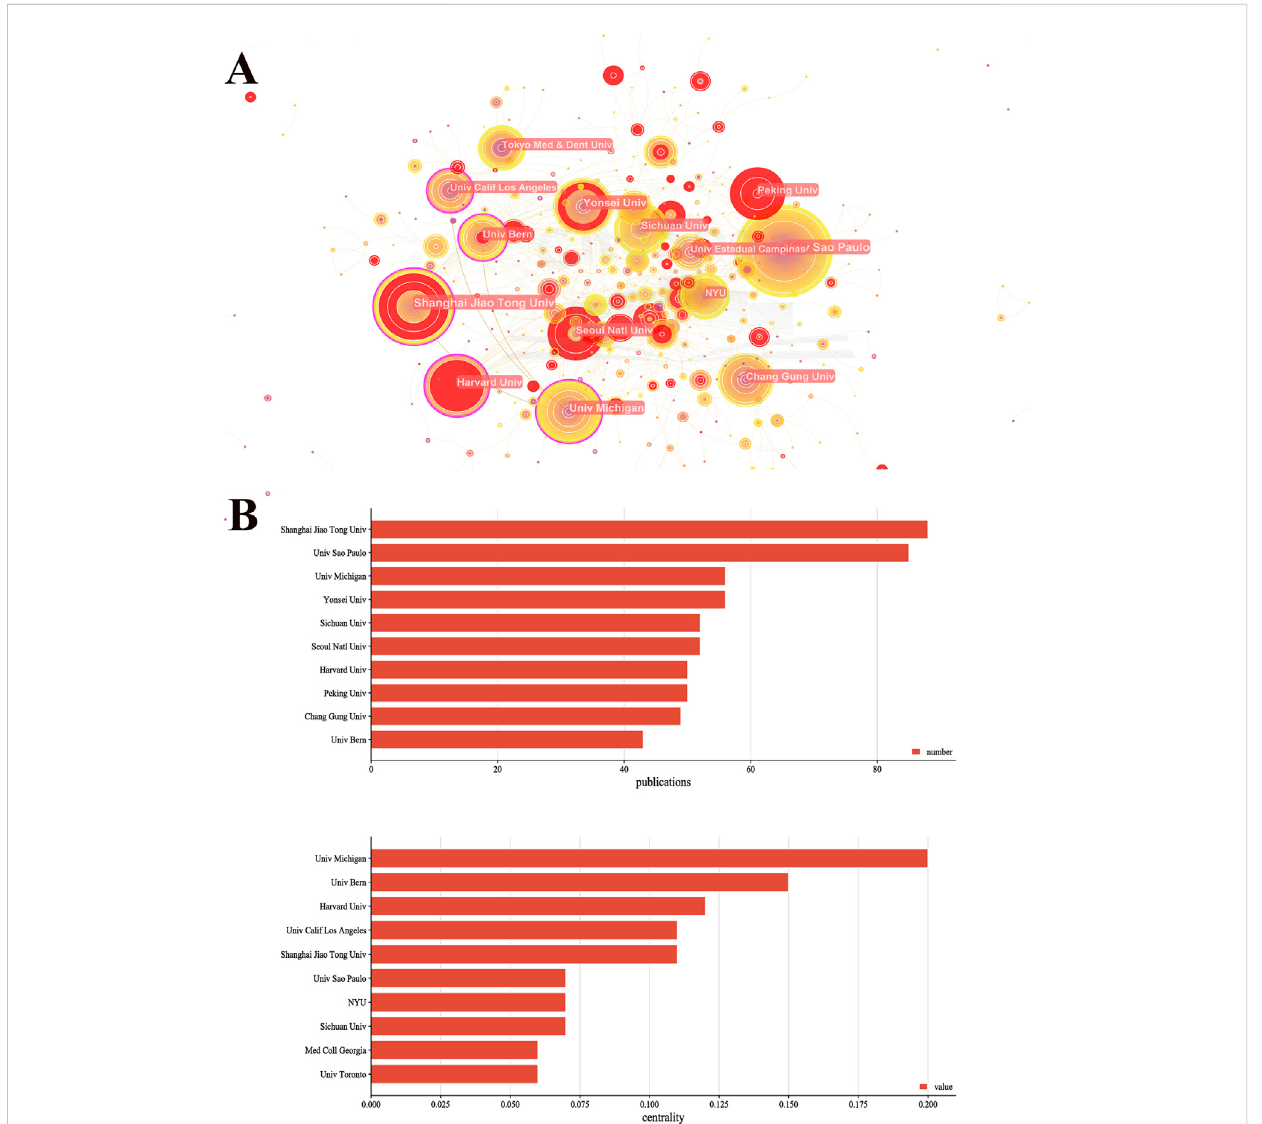
FIGURE 4 Collaboration network of institutions of CiteSpace. (A) Visualization map of institutions. N = 598, E = 678. ( N represents the number of network nodes. E represents the number of connections). (B) The publications and centrality of institutions of mandibular defect research.